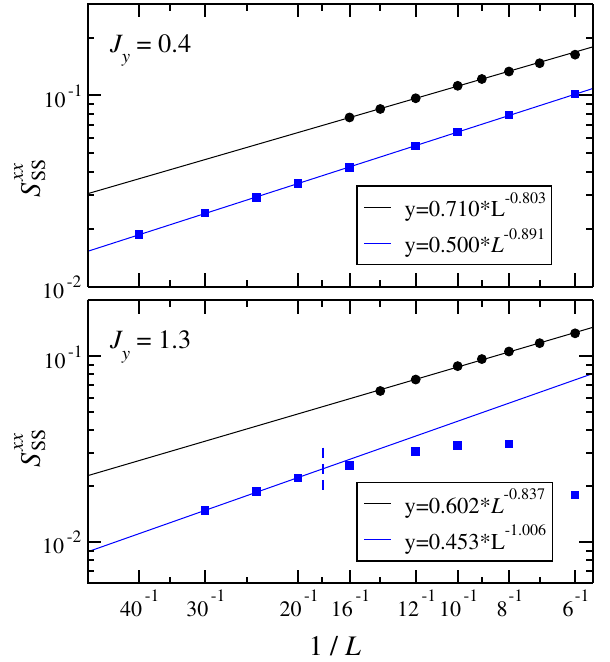
FIG. 6. Scaling of S xx ð 0 Þ as a function of the inverse system SS size L , for two values of J y in proximity of the peaks (see the arrows in Fig. 5). The symbols denote the numerical data, while the continuous lines are power-law fits performed for the data points to the left of the vertical dashed line. The black sets correspond to those of Fig. 5, obtained by simulating a small system with RK and QT approaches. The blue sets have been obtained with MPO simulations, where the CMF has been applied to the two edges. The other parameters are set as in Fig.